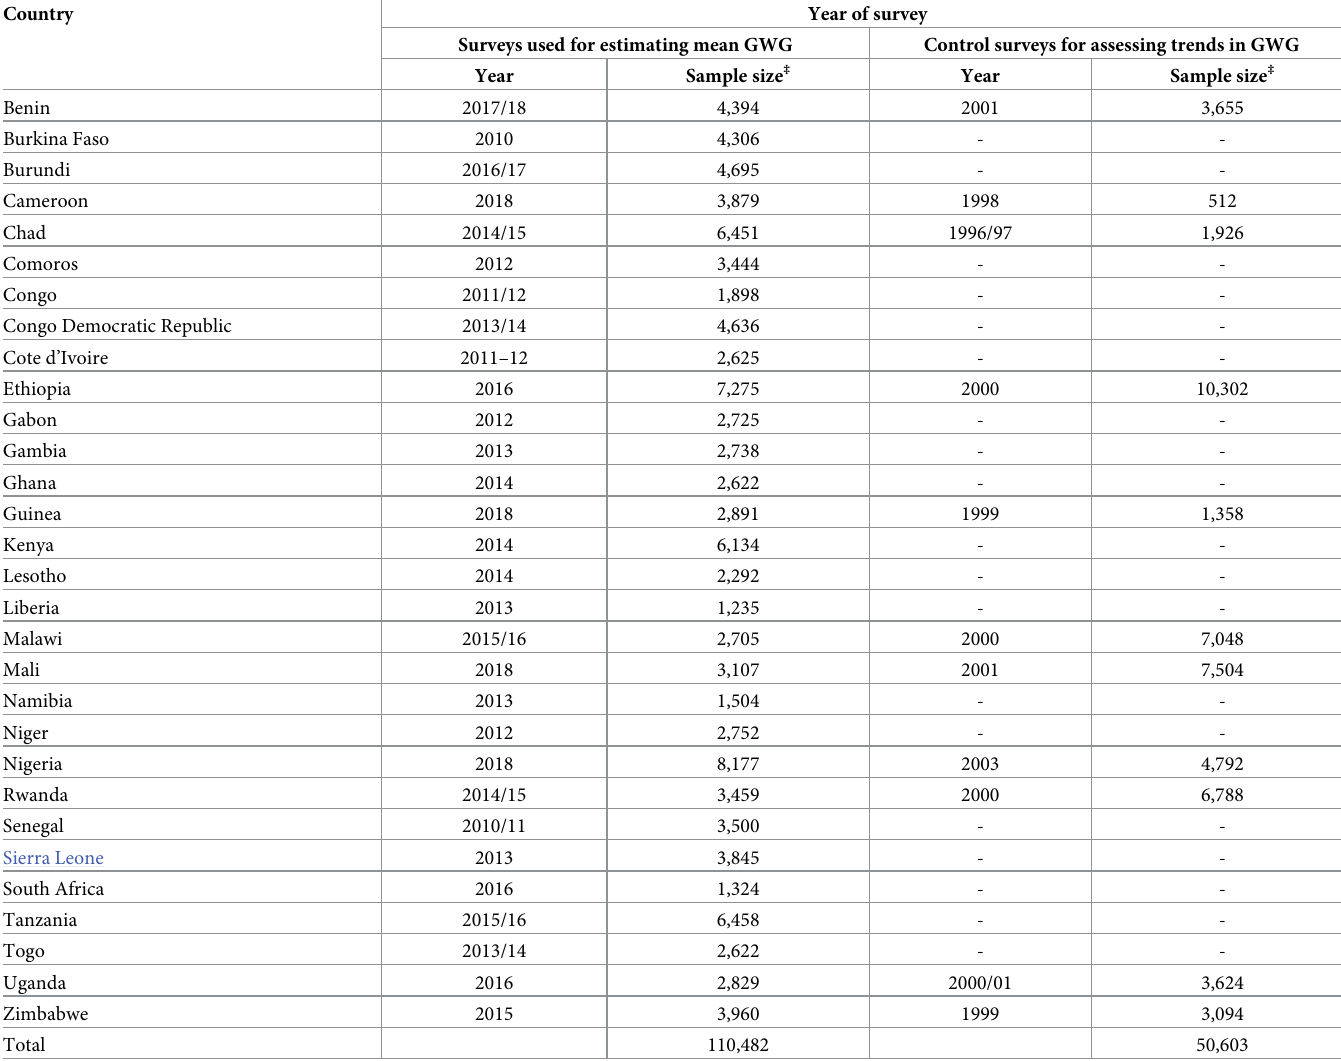
Table 1. Demographic and health surveys included in the analysis.